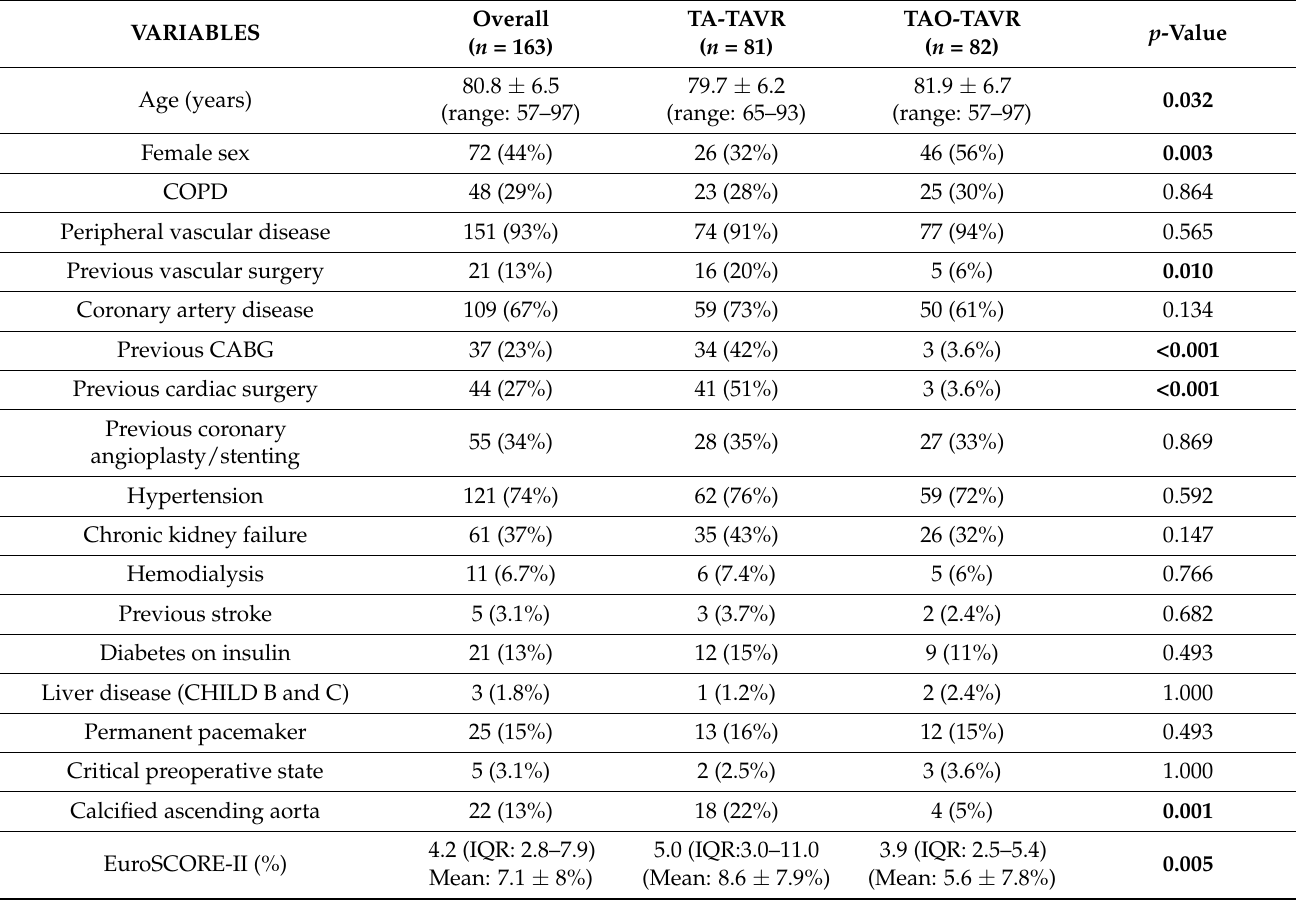
Table 1. Baseline characteristics.